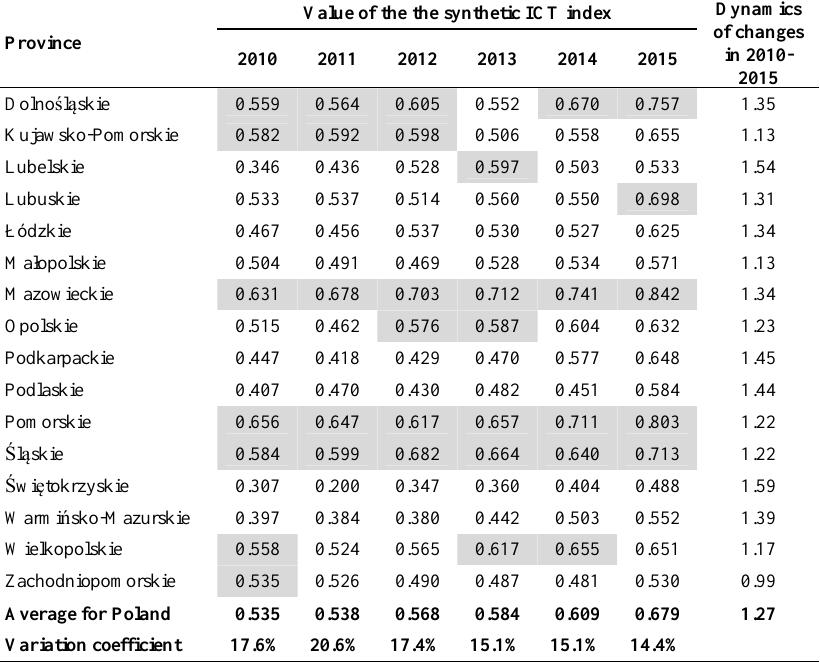
Table 1. Synthetic index of the information infrastructure in provinces between 2010 and 2015